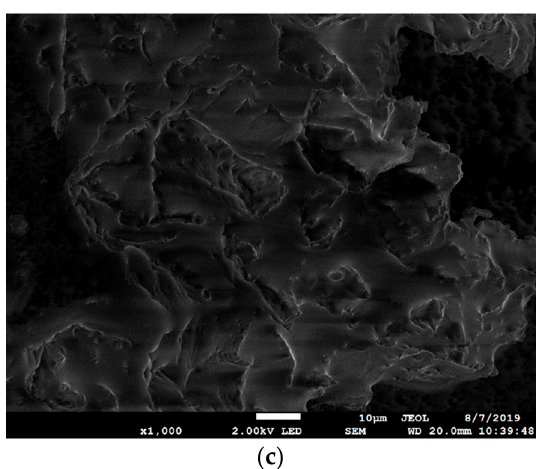
Figure 3. Scanning electron microscopy (SEM) of cells’ surface morphological alterations of the mamey seed samples by ( a ) non-extraction; ( b ) solvent extraction; and ( c ) aqueous enzymatic extraction.